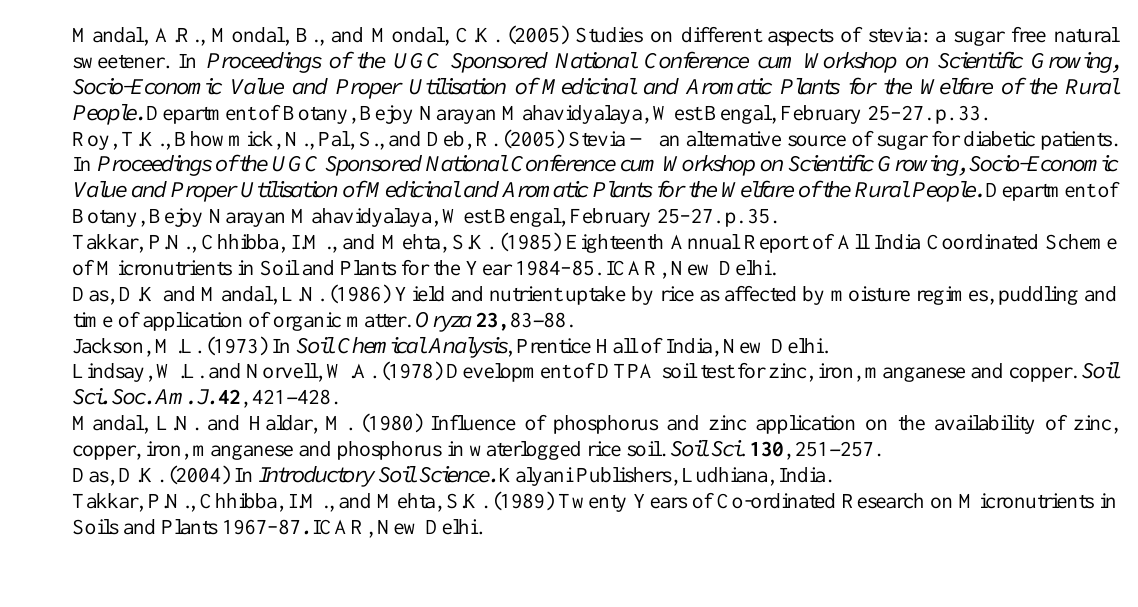
Days after Plant Growth